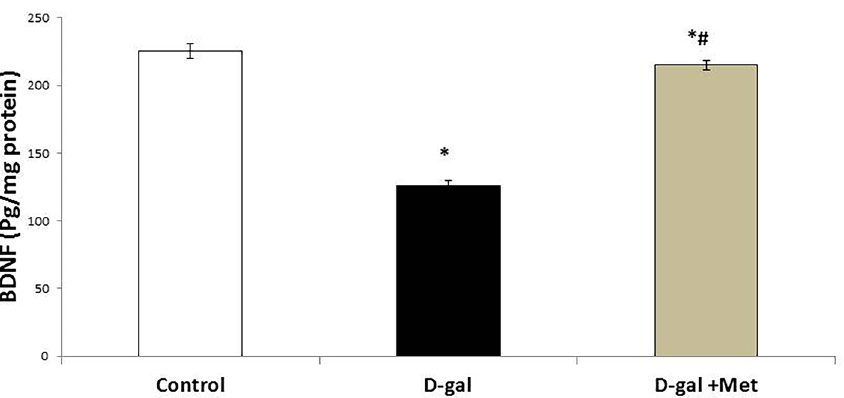
Figure 5. Metformin improves brain BDNF level in D-galactose-induced aging rat model. (*significant when compared to control group, # significant when compared to D-gal group). Data are shown as means + SD (n = 10). ANOVA was used to make group comparisons; Significance = P <